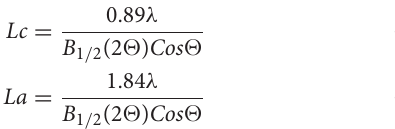
PI sheet is converted into black LRPI material due to laser